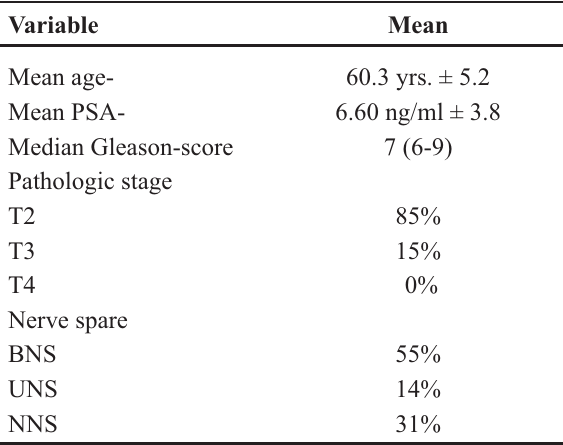
Table 1 – Patient demographics.